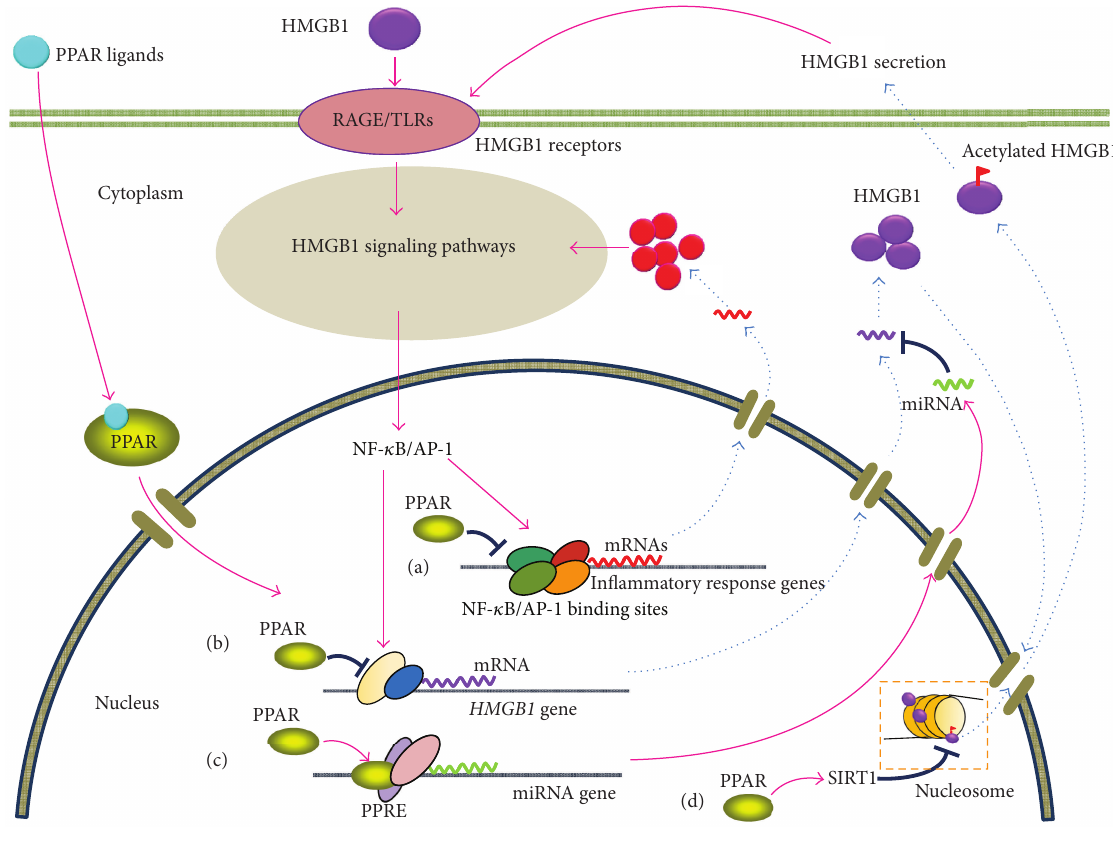
Figure 1: Schematic representation of PPAR ligands targeting HMGB1 via PPARs-mediated mechanisms. See details in text. PPAR: peroxisome proliferator-activated receptor; HMGB1: high mobility group box 1; TLR: Toll-like receptor; RAGE: receptor for advanced glycation end-products; PPRE: peroxisome proliferator response element; AP-1: activator protein-1; NF- 𝜅 B: nuclear factor- 𝜅 B; mRNA: messenger RNA; miRNA: microRNA; SIRT1: silent information regulator